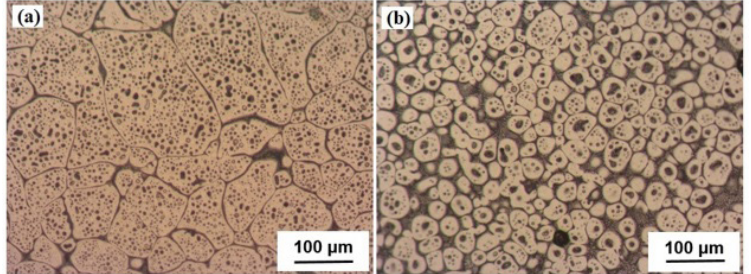
Figure 3. Optical microscope images of ZA27 pure alloys treated at 460 ºC during 20 min and after deformed in thickness: (a) 10% and (b)